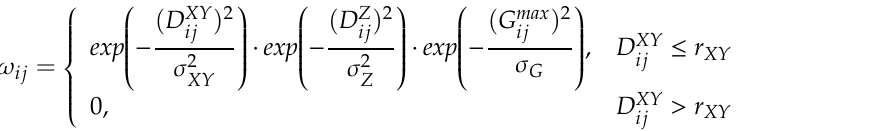
Figure 8. Illustration of the updator part. The skip connection is used to concatenate the output of the aggregator and the input embedding together. Finally, a fully connected (FC) layer follows to update and get the refined output embedding.